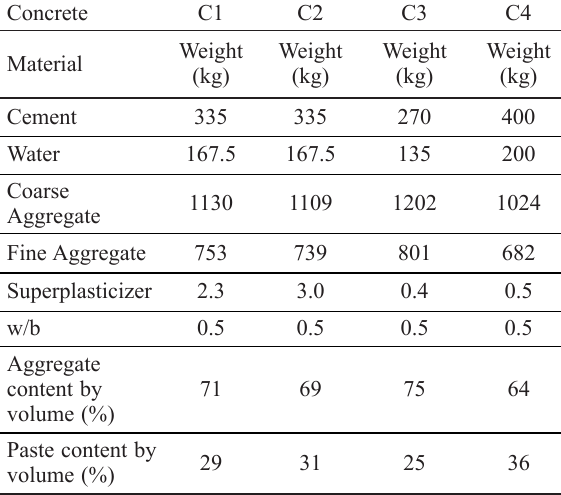
Table 1. Concretes mixture design (amounts in kg per cubic meter of